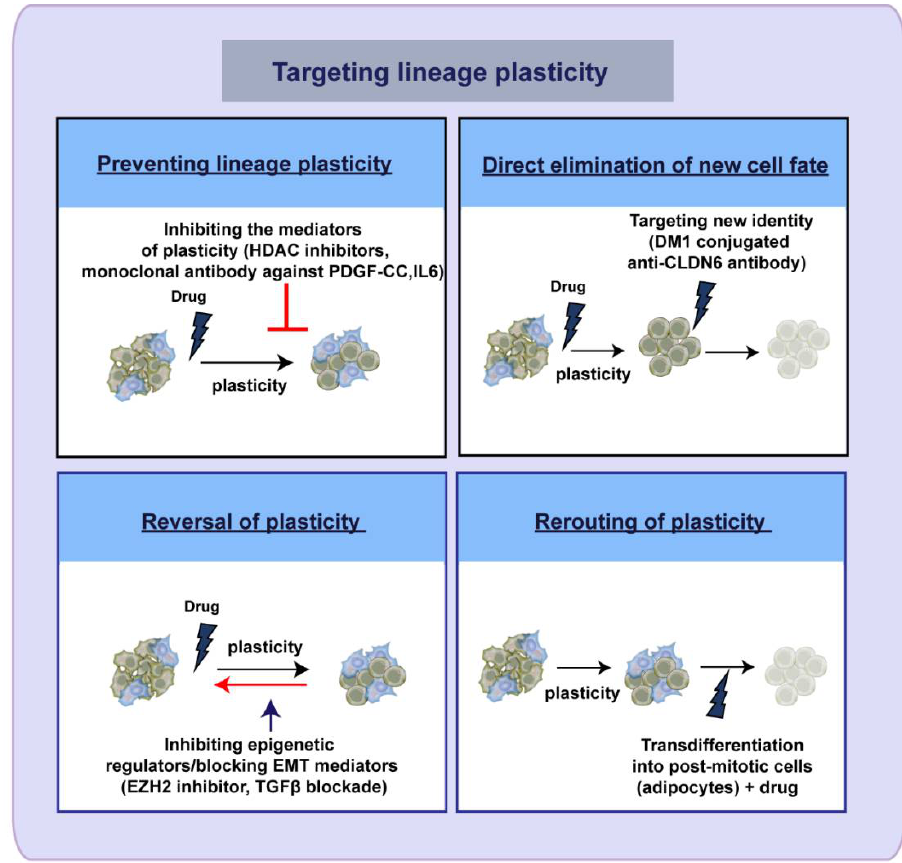
Figure 3. Therapeutic strategies to target the lineage plasticity. Schematic showing the approaches used to target cancer lineage plasticity. Lineage plasticity can be prevented by directly inhibiting the mediators regulating cellular plasticity (by inhibiting cancer cell-associated proteins (HDACs KDM, IL6-STAT3 signaling) and microenvironment-derived factors (PDGF-CC)). Another approach is to eliminate the new cell fate adopted by the cells through lineage switching (e.g., using cytotoxic drug-conjugated antibody against CLDN6). The third approach is to reverse the lineage plasticity of cancer cells (e.g., by inhibiting the epigenetic modulators such as EZH2 or by blocking EMT mediators like TGF β ). Another strategy that has recently gained attention is to exploit the intrinsic cellular plasticity of the tumor cells by transdifferentiating them into alternate cell lineages that are post-mitotic and thereby rerouting the lineage plasticity. Combining chemo/targeted therapy along with the transdifferentiating drug will facilitate the effective eradication of tumor cells.